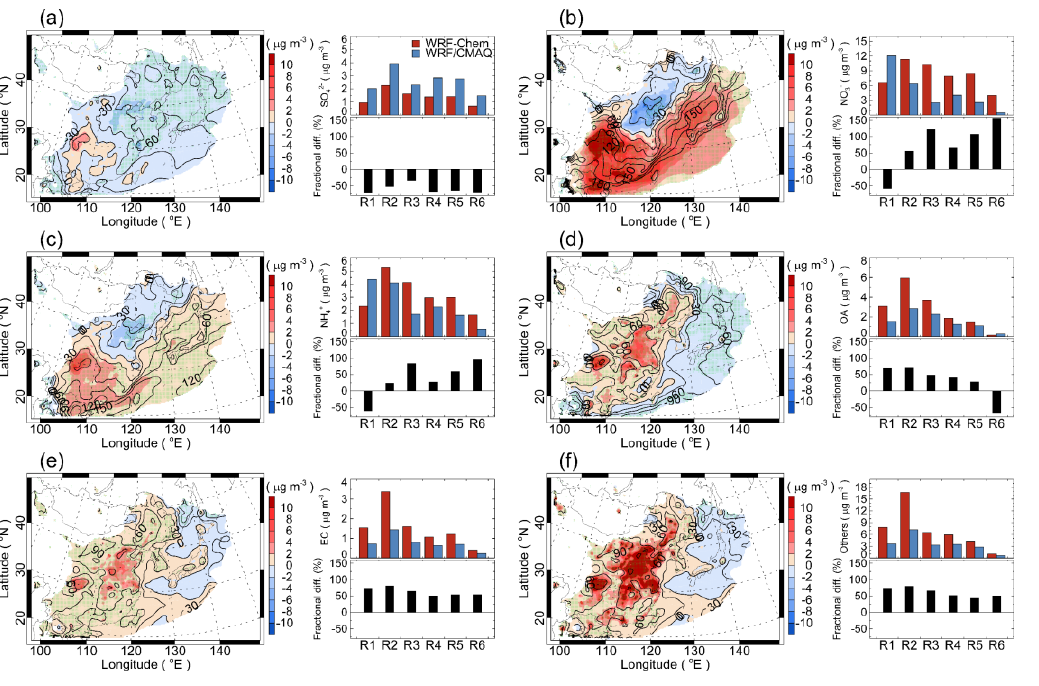
Figure 10. Spatial distribution of the concentration difference (shaded) and the fractional difference (line contour) in the surface PM 2.5 chemical components simulated by the WRF-Chem and WRF/CMAQ models. ( a ) sulfate, ( b ) nitrate, ( c ) ammonium, ( d ) organic aerosols, ( e ) elemental carbon, and ( f ) non-reactive PM 2.5 primary chemical components. The mean concentrations and fractional differences at six subdivisions were shown on the right in each figure. Green dots denote the areas where the relative difference is statistically significant within 95%.